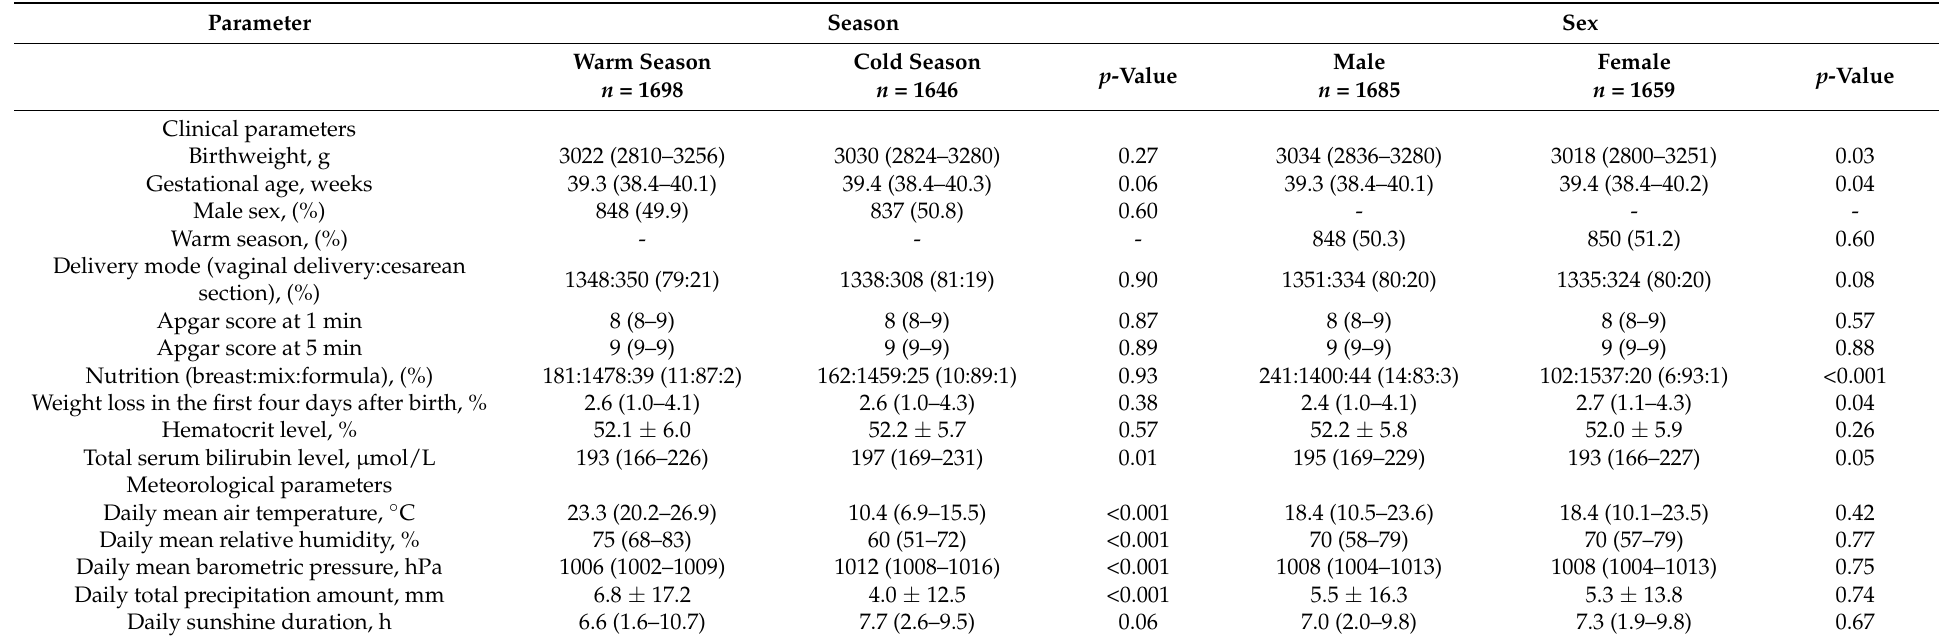
Table 1. Seasonal and sex differences in the characteristics of the study population and meteorological